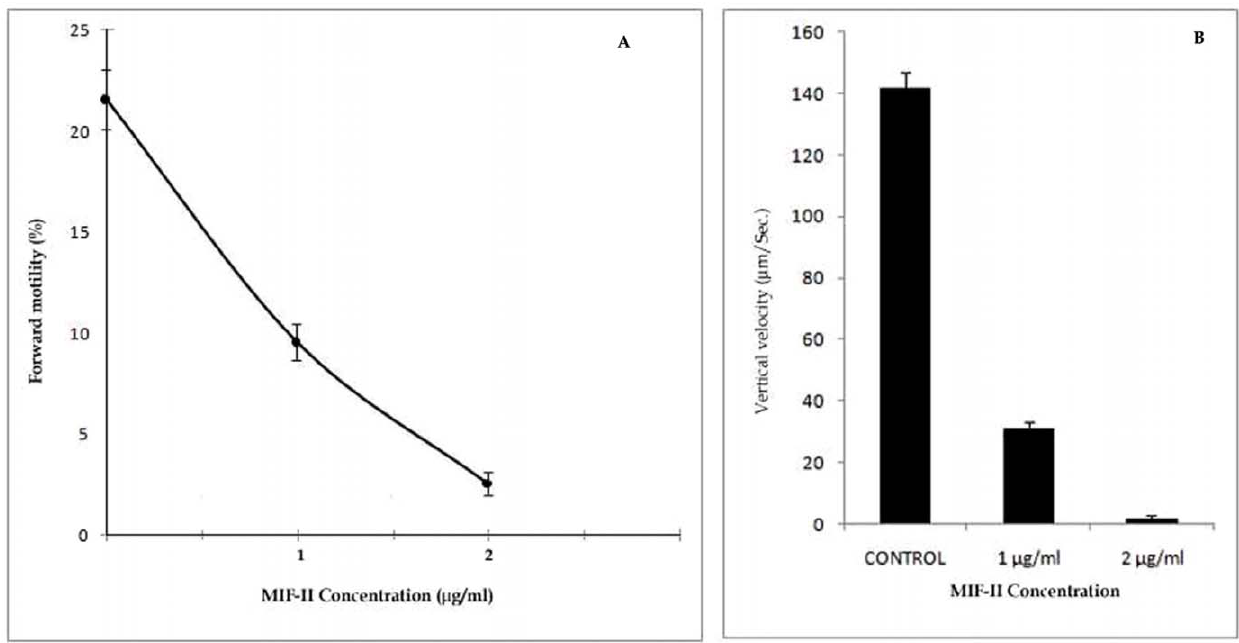
Figure 8. Effect of different concentration of MIF-II on human sperm. A) Effect of MIF-II on forward motility of human sperm. B) Effect of MIF- II on vertical velocity of human sperm.